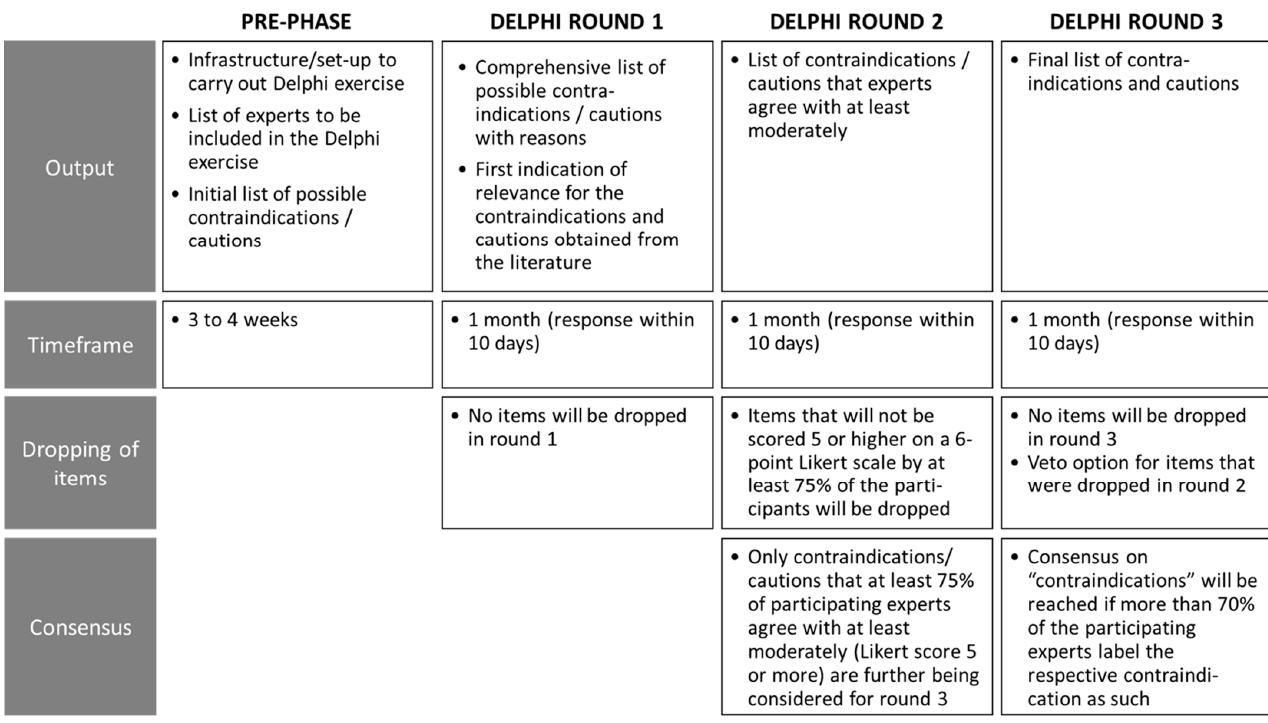
Figure 4. Outputs, planned timeframes, items to be dropped and requirements for consensus of each Delphi process round.